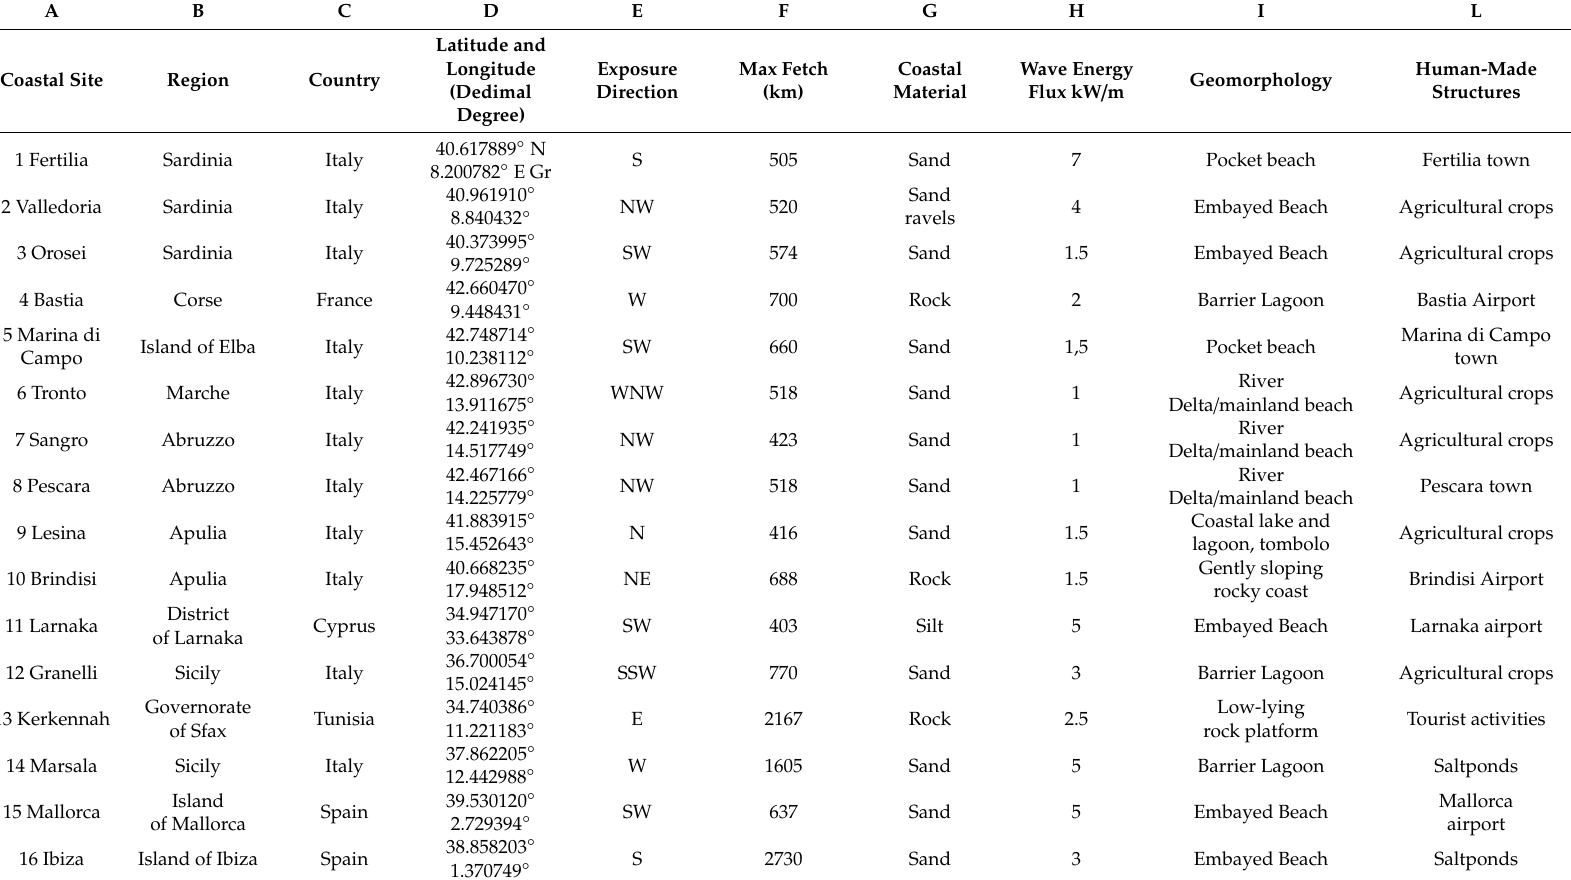
Table 4. A: coastal areas chosen for our research; B, C: region and Country; D: coordinates; E: wind \ wave exposure; F: maximum fetch (km); G: geological coastal material; H: annual mean energy flux (kW \ m) according with [56]; I: kind of geomorphological outcrop; L: human made structures occupying the area planned to be submerged on